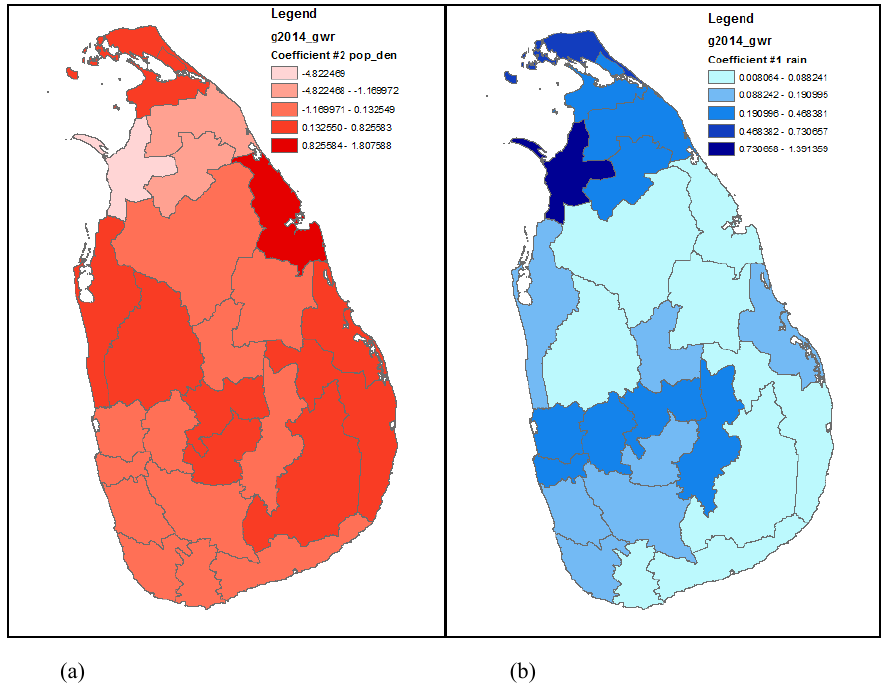
Figure 4: spatial distribution of regression coefficients for (a) population density (b)